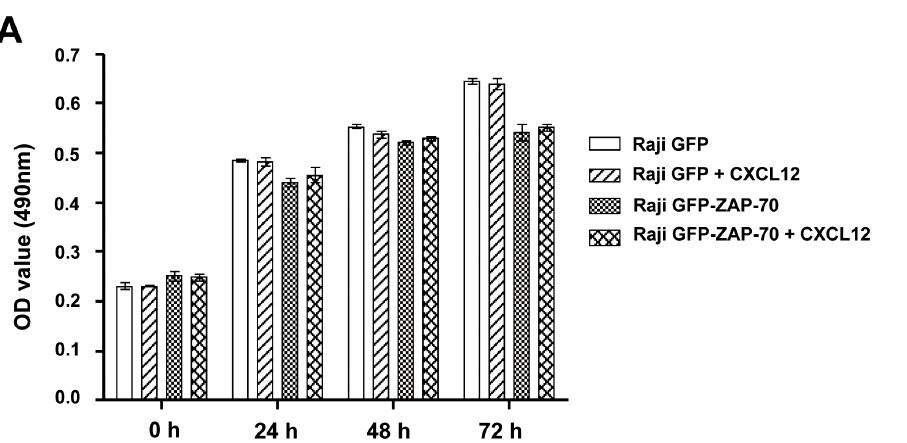
Figure 5. CXCL12 does not affect proliferation of Raji cells. Proliferation of Raji cells exposed to chemokine CXCL12 after 24, 48 and 72 hours was measured by MTS-assay. The mean optical density (OD) values at 490 nm 6 SEM from 5 replicates are depicted in the graph.